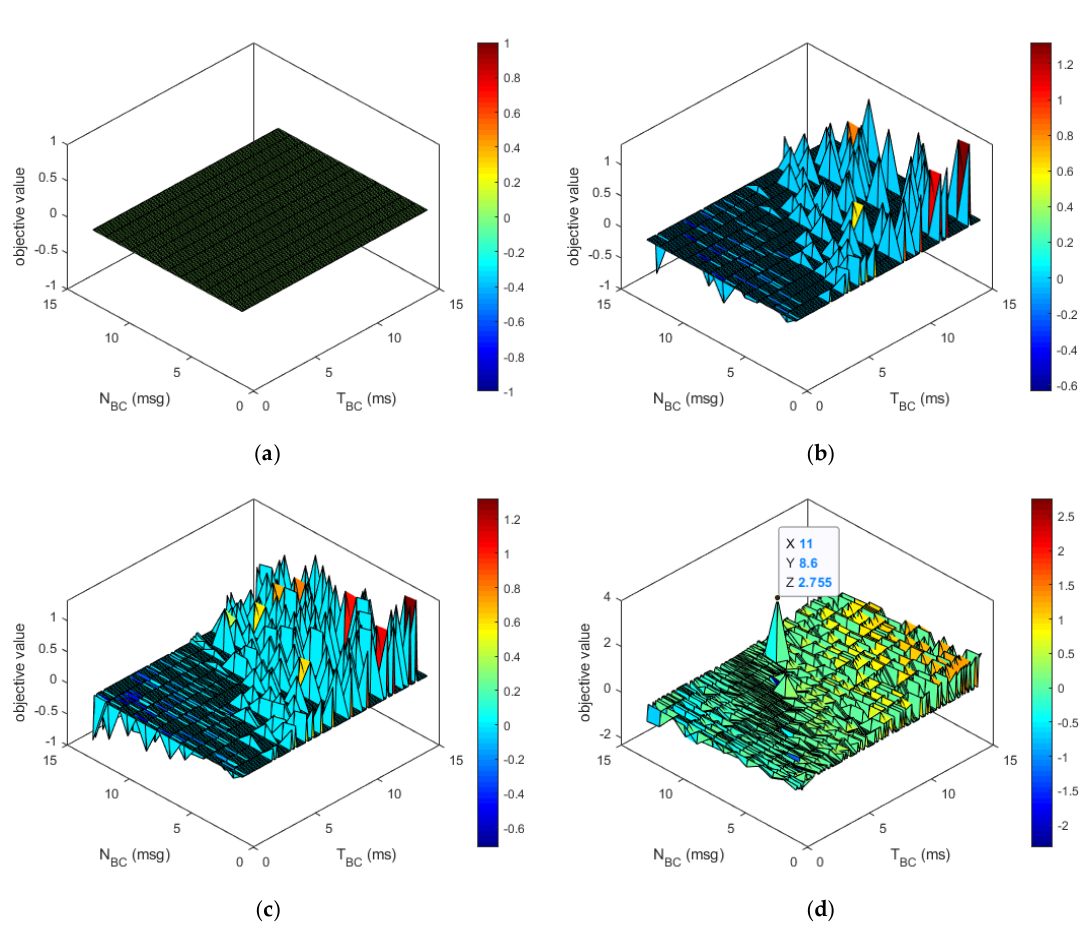
Figure 3. The visualization of the objective values in the search space according to iterations in the Monte Carlo optimization (MCO). ( a ) Initialization; ( b ) intermediate iteration; ( c ) intermediate iteration; ( d ) final iteration.